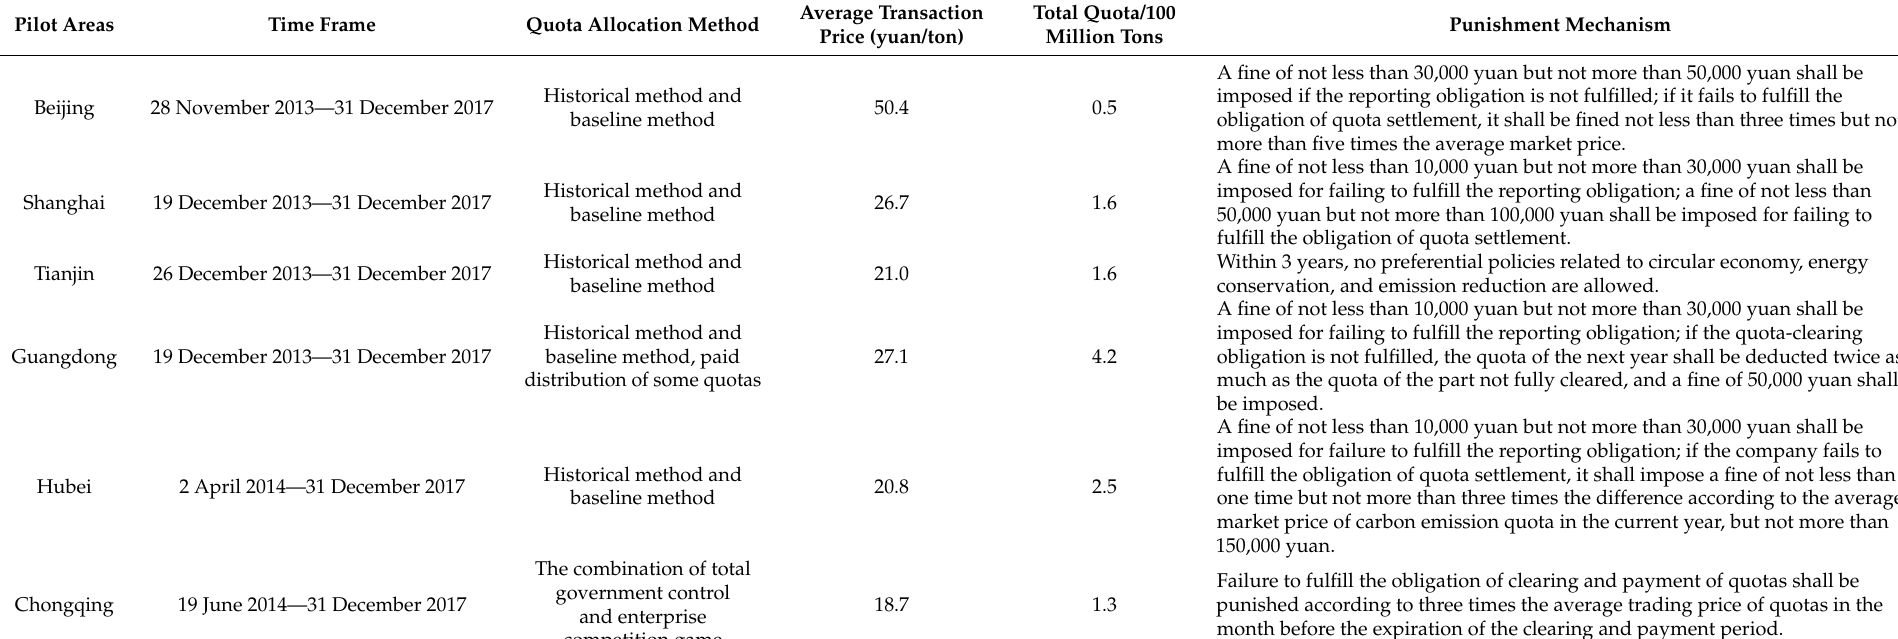
Table 7. Operations of the pilot carbon